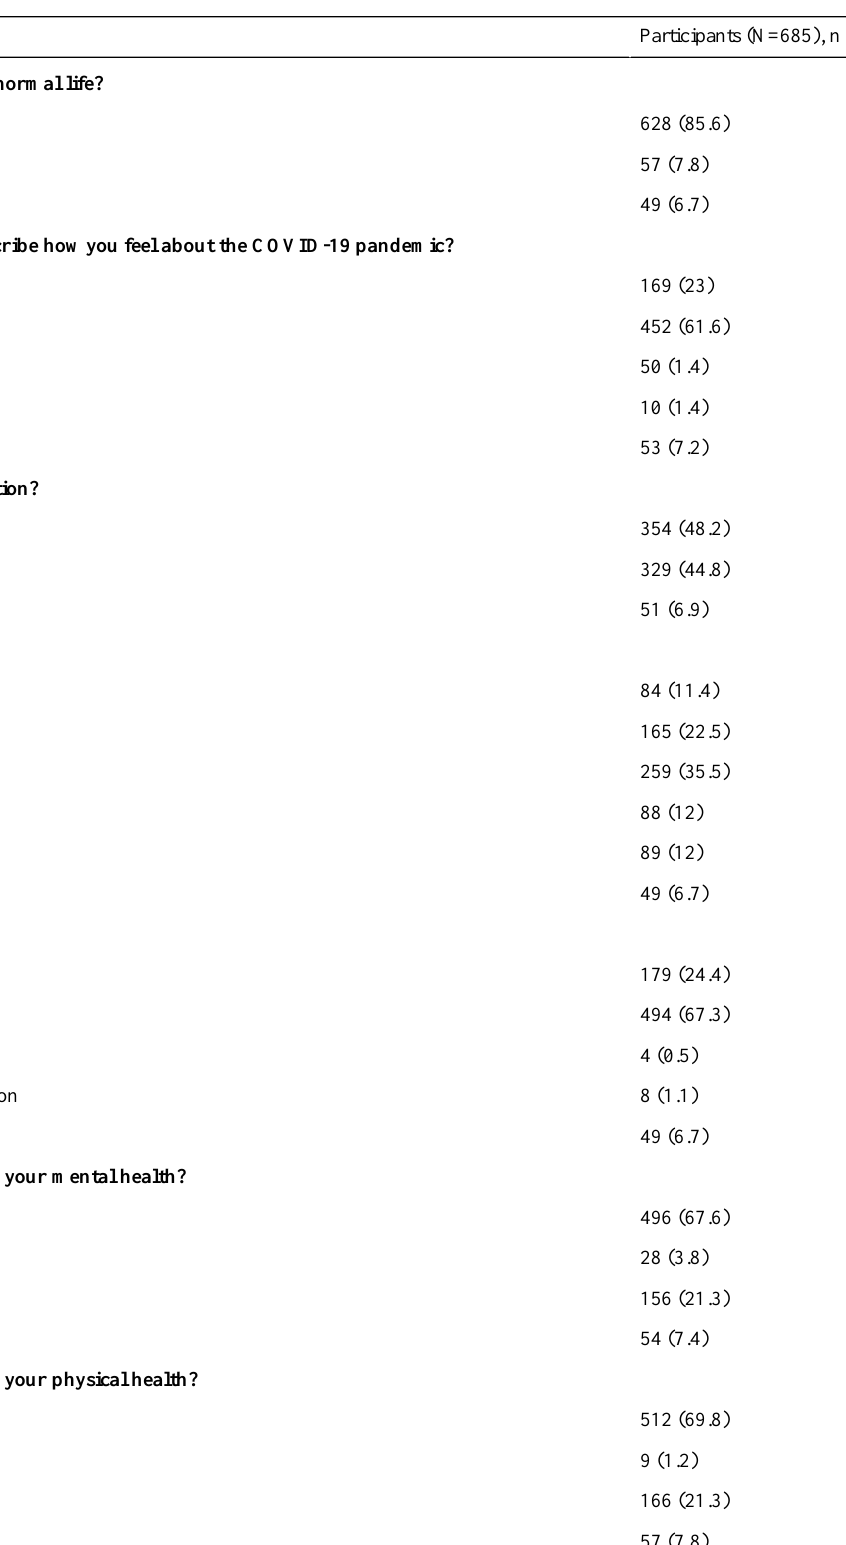
Table 2. Descriptive